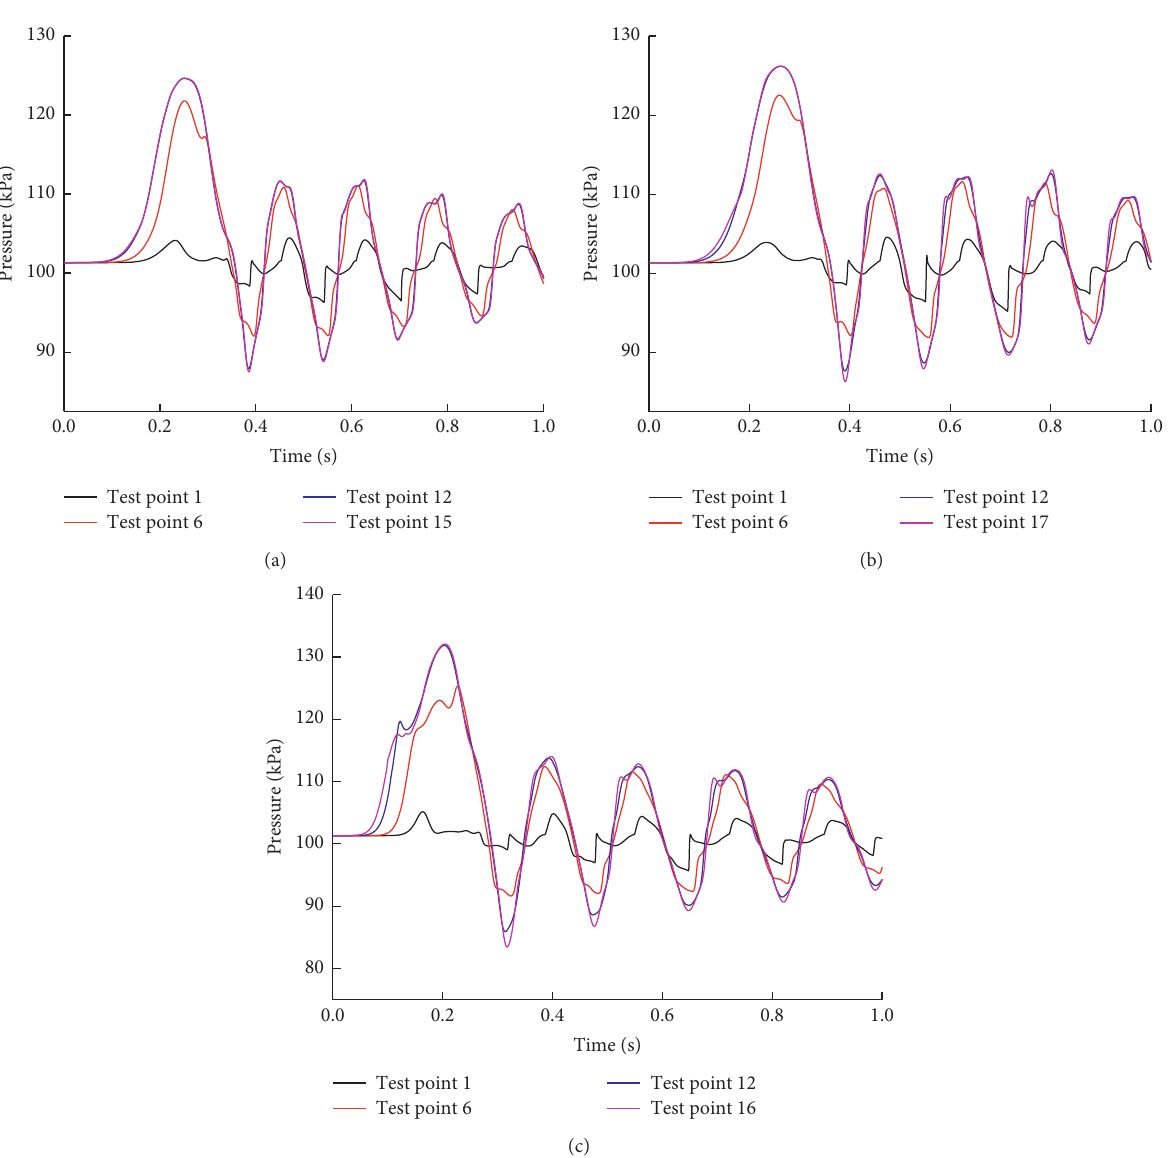
Figure 9: Curves of pressure vs. time under different inspection well depth: (a) 2m; (b) 4m; (c)